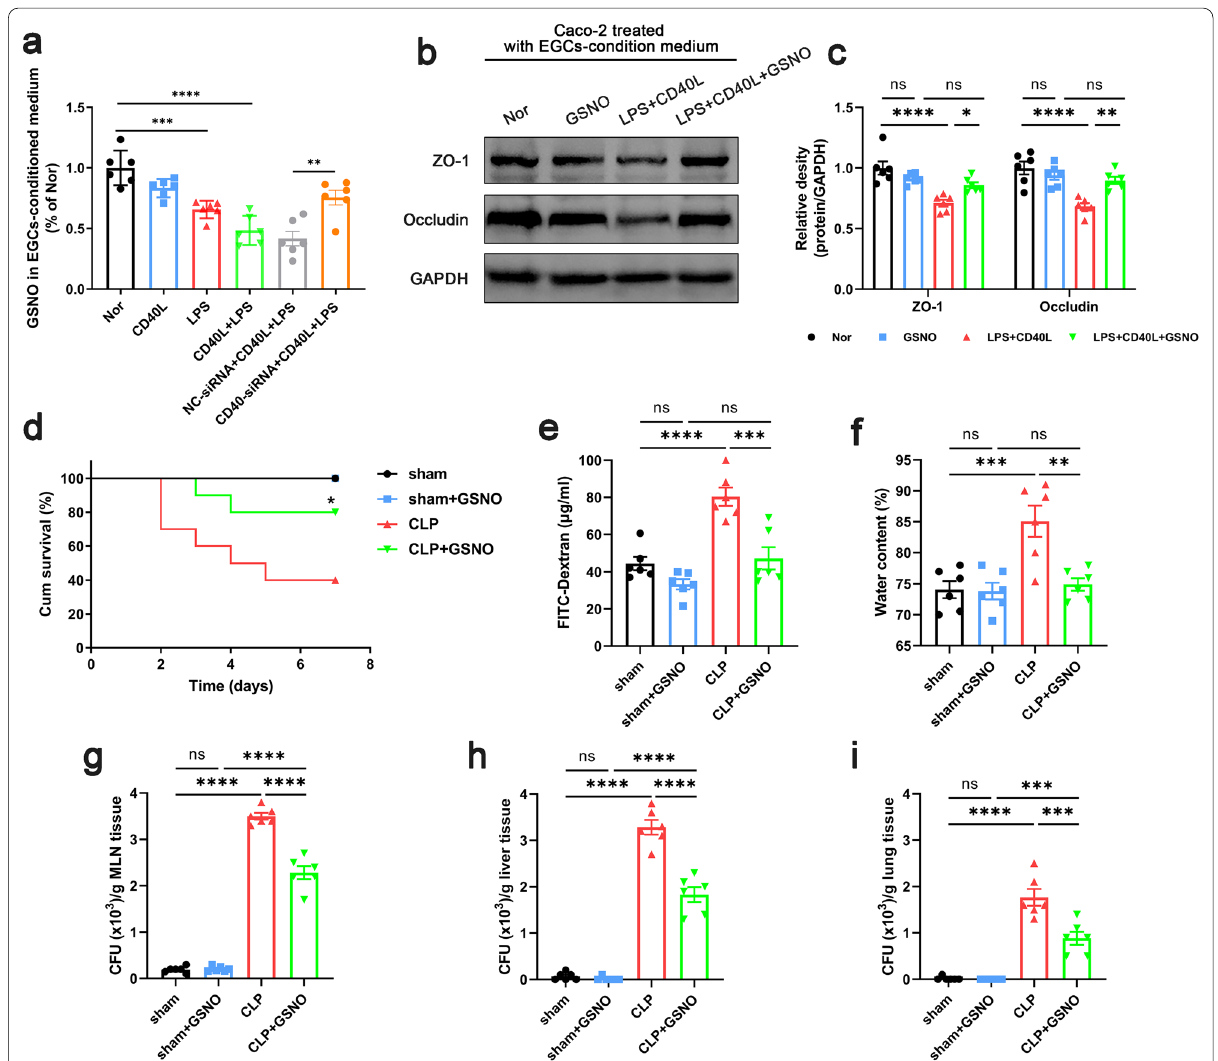
Fig. 6 Effect of GSNO pretreatment on intestinal epithelial barrier. In vitro, EGCs-conditioned medium was collected to measure the GSNO level ( a ) (n 6). The levels of ZO-1 and occludin expression in Caco-2 cells were evaluated by western blot after the stimulation of EGCs-conditioned = medium with or without GSNO 50 µM) supplementation ( b , c ) (n 6). In vivo, GSNO was administrated intraperitoneally at 10 mg/kg/day for 7 days = before CLP. 24 h after CLP, mice were sacrificed, and tissue samples were collected. d The survival percentage of the mice was investigated within 7 days after CLP by survival curves (n 10). Intestinal barrier permeability was indicated by serum FITC-Dextran levels ( e ) (n 6), water content = = ( f ) of gut (n 6), and colony-forming units (CFUs) ( g – i ) from mesenteric lymph node (MLN), liver and lung (n 6). The data are presented as the = = mean SEM, * P < 0.05, ** P < 0.01, *** P < 0.001, **** P < ±